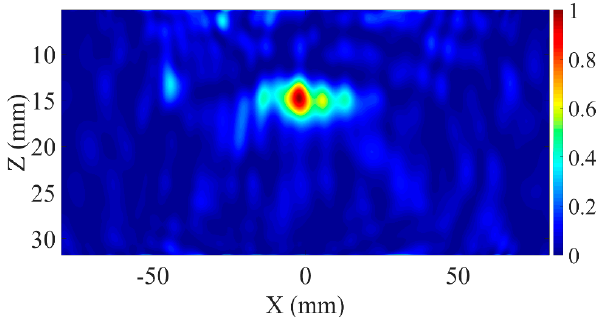
Figure 9. Reconstructed mm-wave image for Test 3 .